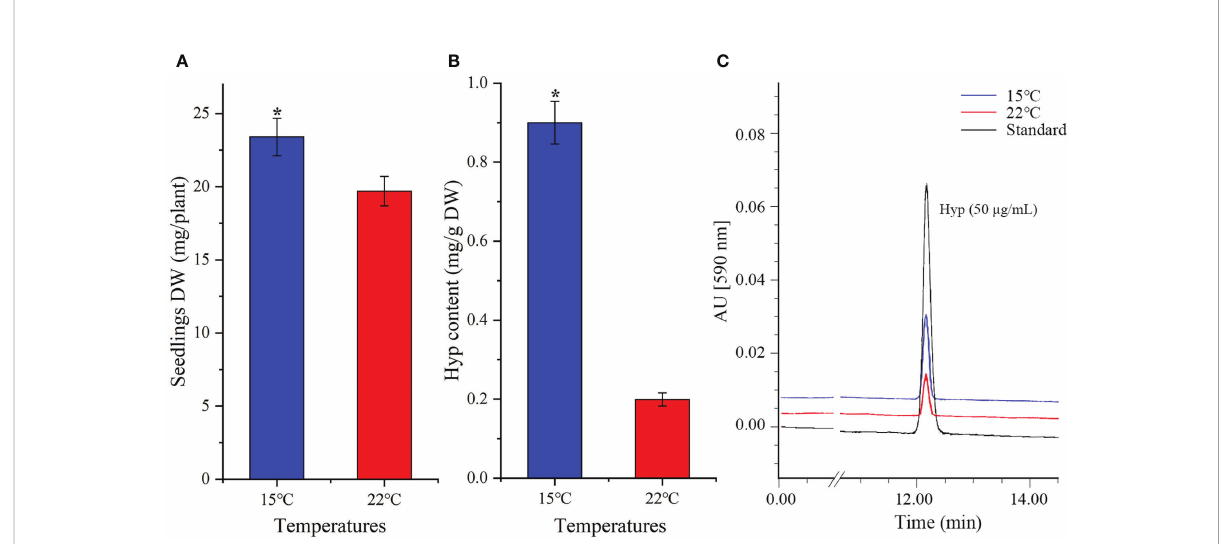
FIGURE 1 Seedlings DW (A) , Hyp content (B) and representative chromatograms of HPLC (C) in H perforatum grown at 15 and 22°C. Values of DW are average with their standard deviations (n = 25), and values of Hyp content are average with their standard deviations (n = 3). The “ * ” represents a signi fi cant difference ( P < 0.05) between 15 and